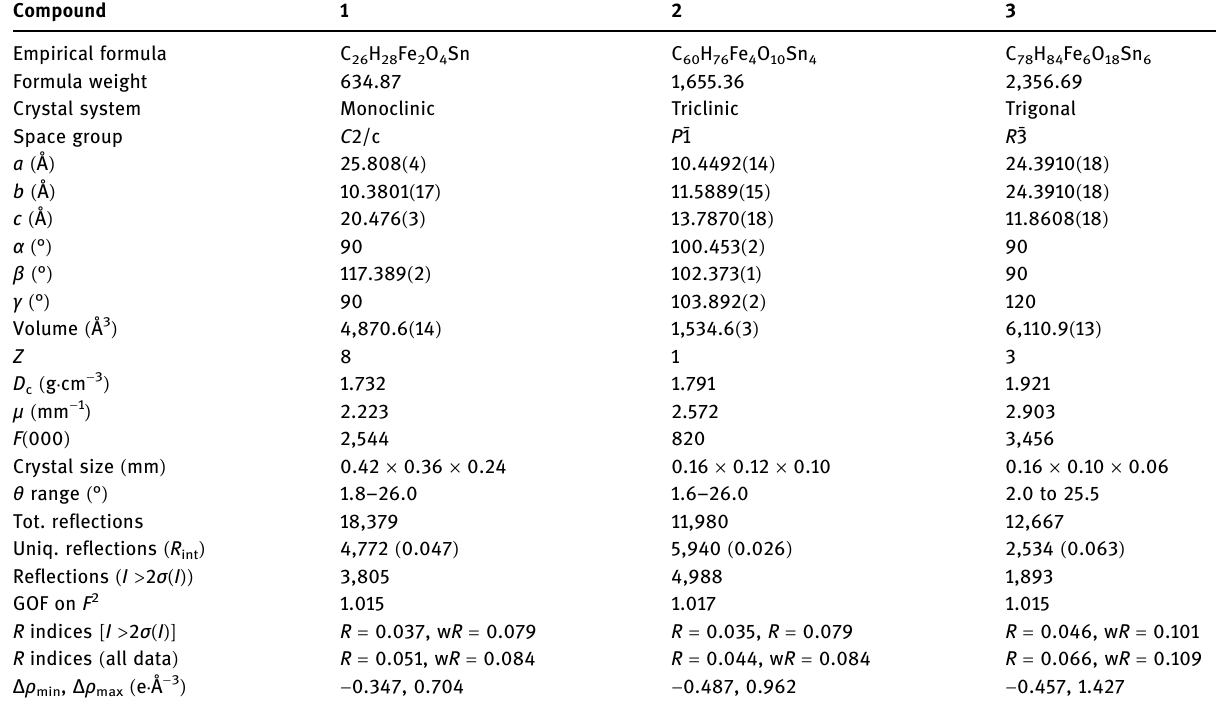
Table 2: Crystallographic and re fi nement data of 1 –